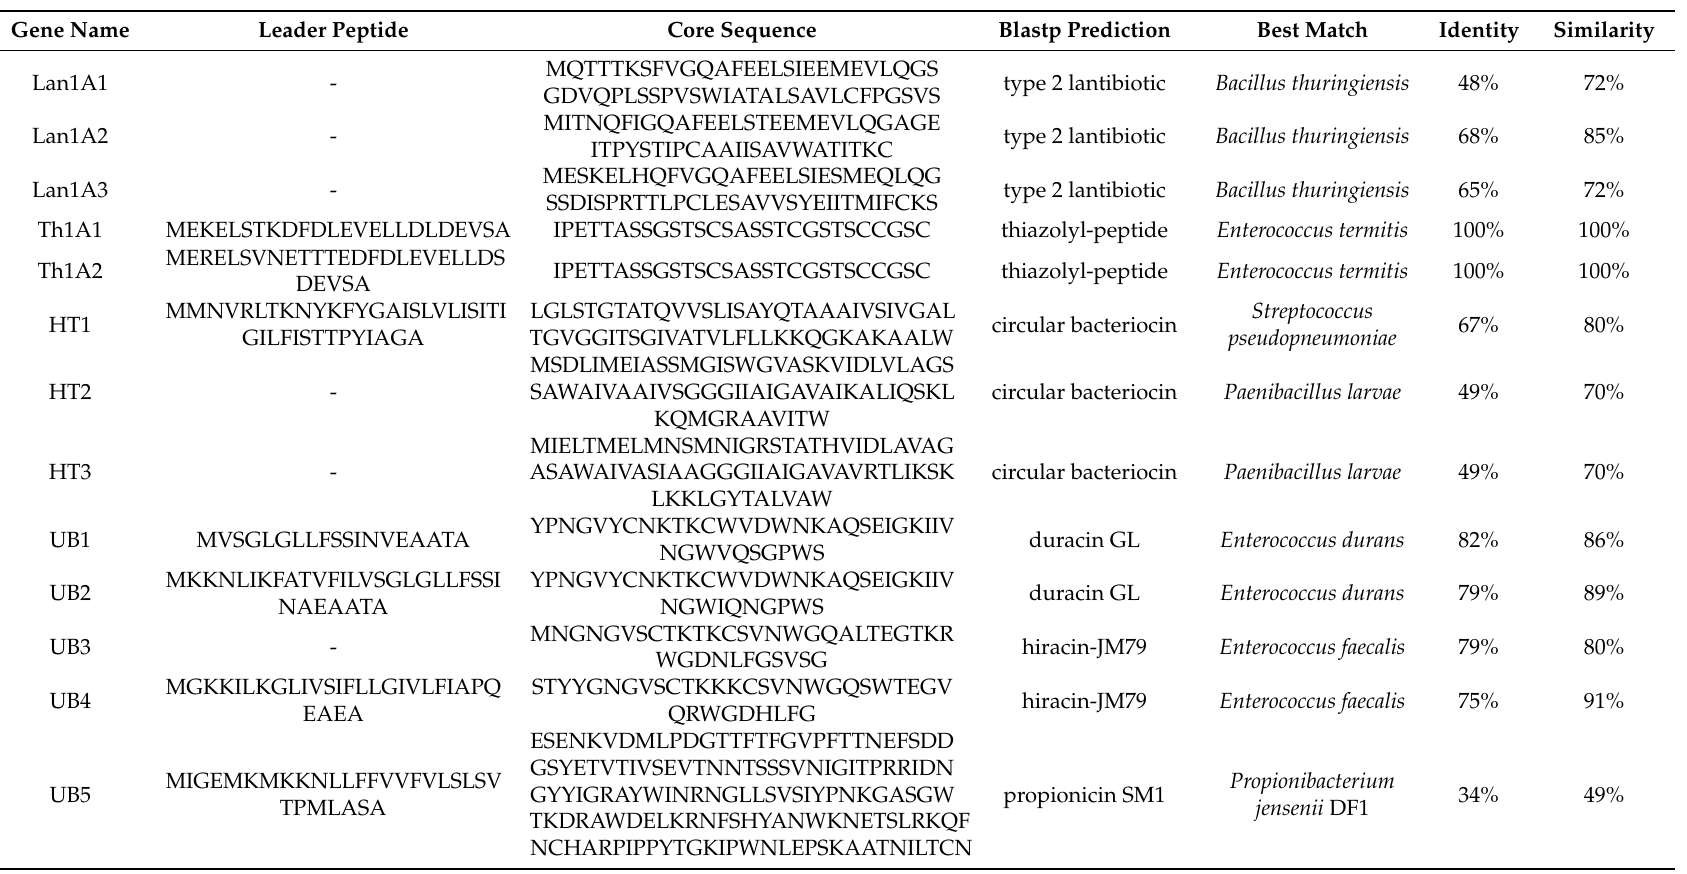
Table 1. Undescribed ribosomally synthesized and post-translationally modified peptides (RiPPs) sequence prediction. Names were arbitrarily given depending on predicted RiPP classes. Sequence prediction was achieved with AntiSMASH, and the BAGEL leader sequence was predicted with SignalP 5.0. Alignment by Blastp of the core sequence to the non-redundant protein sequence database (nr) was used to predict the RiPP class and the closest known